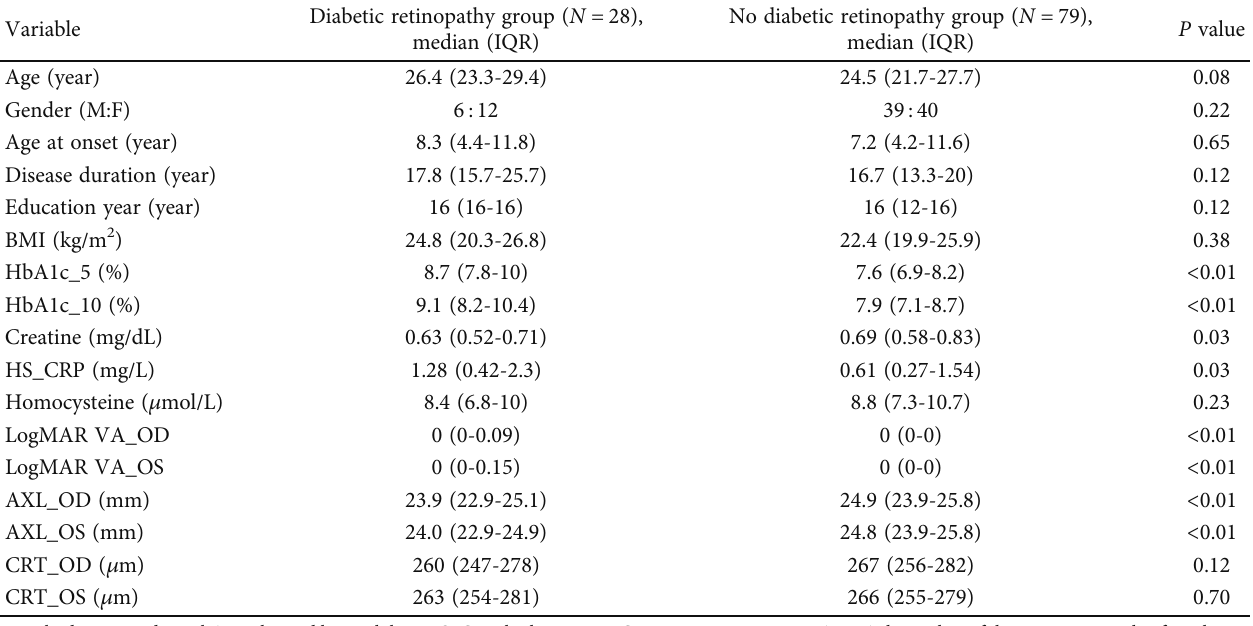
Table 3: Comparison of clinical and ophthalmic variables between patients with and without diabetic retinopathy in T1D. Diabetic retinopathy group ( N = 28 Variable